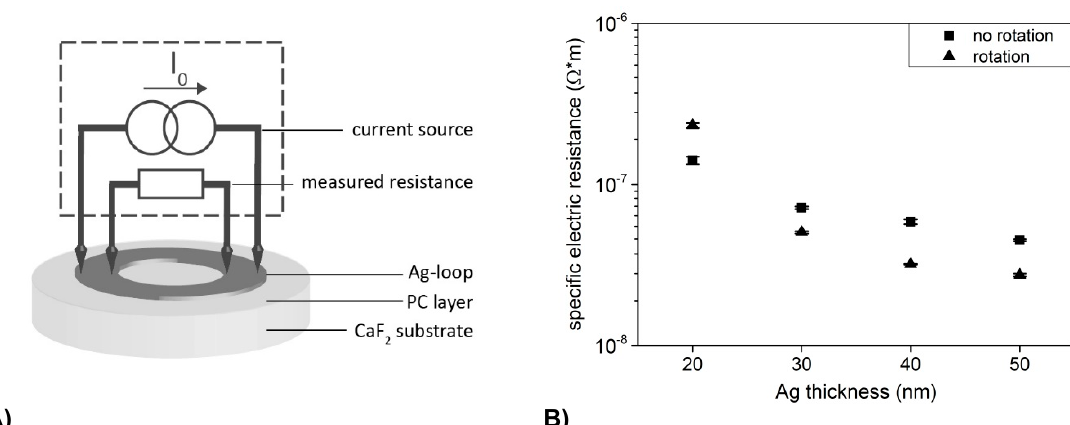
Figure 5. ( A ) Experimental set-up for determination of the resistance of the Ag loop. ( B ) Measured specific electric resistance depending on Ag loop thickness. Variation of evaporation process contained static and rotating samples during Ag deposition.